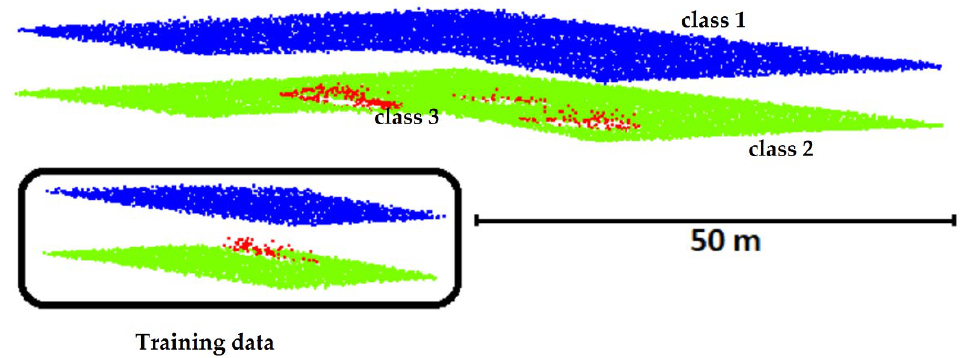
Figure 2. Three classes in the ALB point cloud (blue—water surface, class 1; green—seabed, class 2; red—points on the object on the seabed, class 3).